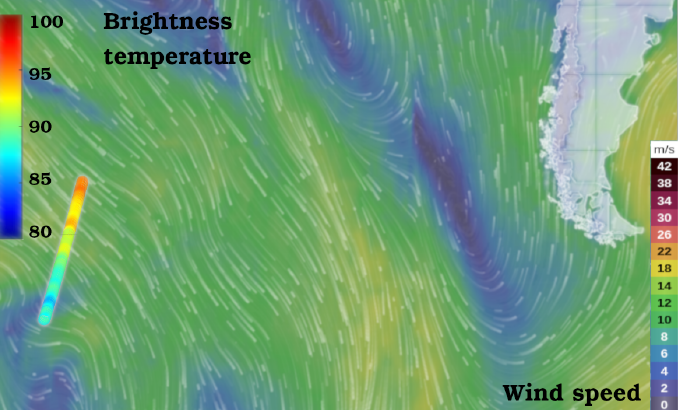
Figure 8. South Pole track overlaid with the wind speed over the ocean, retrieved from Ventusky